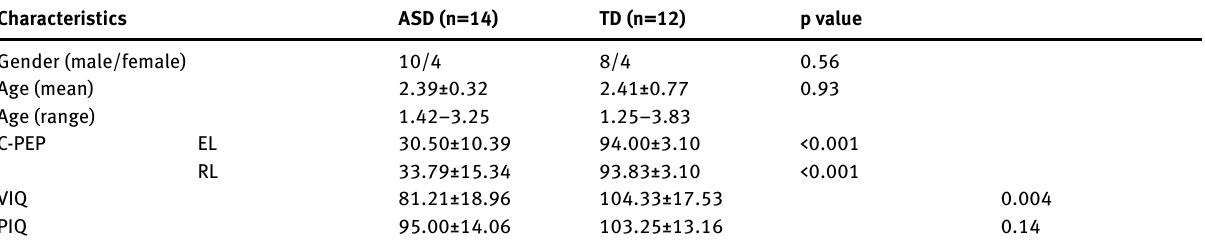
Table 1. Participant characteristics for autism spectrum disorder (ASD) toddlers and typically developing (TD) controls